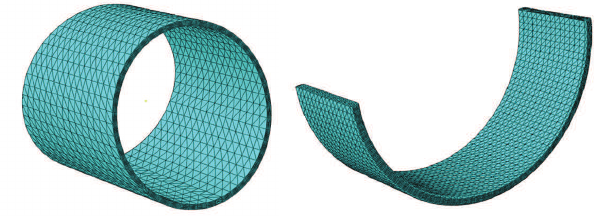
Fig. 5. Mesh grid with local density on bushing and bearing insertions